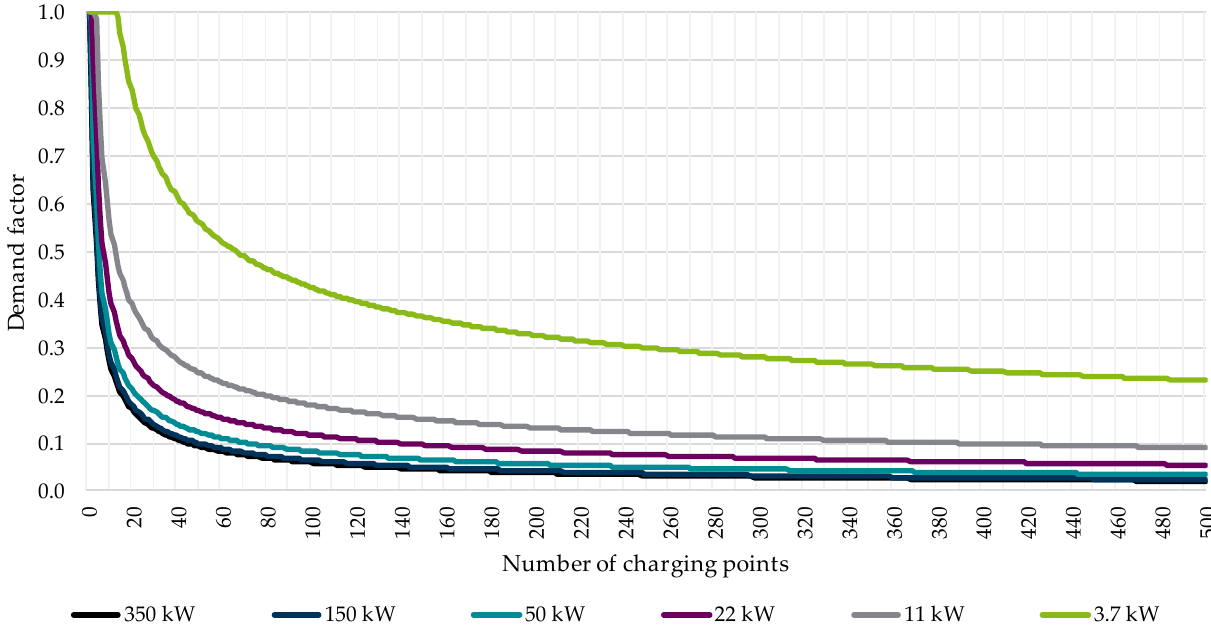
Figure 11. Demand factors (ordinate) for the area type “Urban Region: Metropolis” and six charging powers.